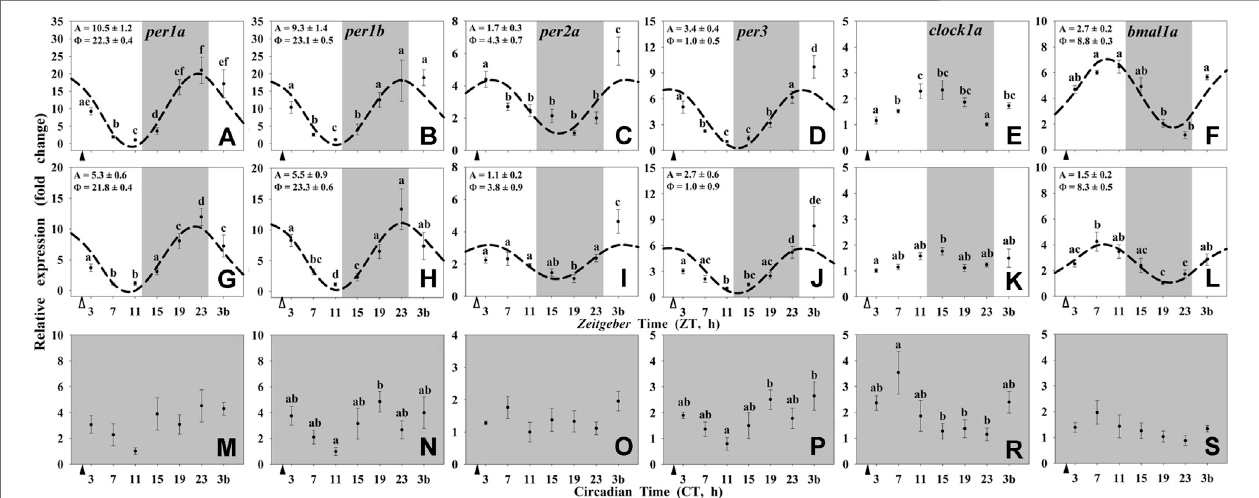
FIGURE 1 | Daily pro fi le of clock genes transcripts in the hypothalamus of gold fi sh maintained under different lighting conditions and feeding protocols. Grey area indicatesthedarkperiod.Feedingtimeisindicatedbytrianglesinthex-axis(solid, ▲ ,scheduled feedingat ZT/CT2;white, Δ ,randomfeedingwiththelastmealatZT2). Data are shown as mean ± SEM ( n = 5 – 7) in relative units (2 − ΔΔ Ct method). Different letters indicate signi fi cant differences (ANOVA p < 0.05, SNK post hoc test). When Cosinor ( SE(A)/A < 0.3 ) was signi fi cant and A > 1 , periodic sinusoidal functions were represented as dashed curves with the corresponding amplitudes and acrophases ( A and Φ ,